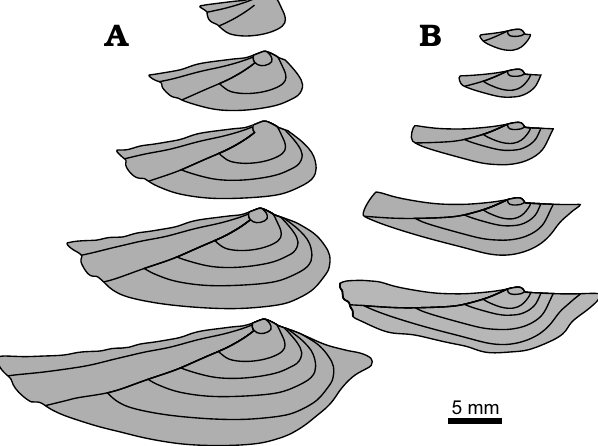
Fig. 9. Ontogenetic series of pachydomid bivalves Leinzia similis (sensu lato) ( A ) from the Yaguari Formation (after Morton and Herbst 1990) and Leinzia similis (sensu stricto) DGP/7-85 ( B ) from the Serrinha Member, Rio do Rasto Formation. Sketches based on external comarginal ornamen- tation (rugae and growth lines) of individual shells. Note the differences in the shell shape of both specimens: double posterior carina (A), the anterior rostrum developed since the early ontogenetic stages